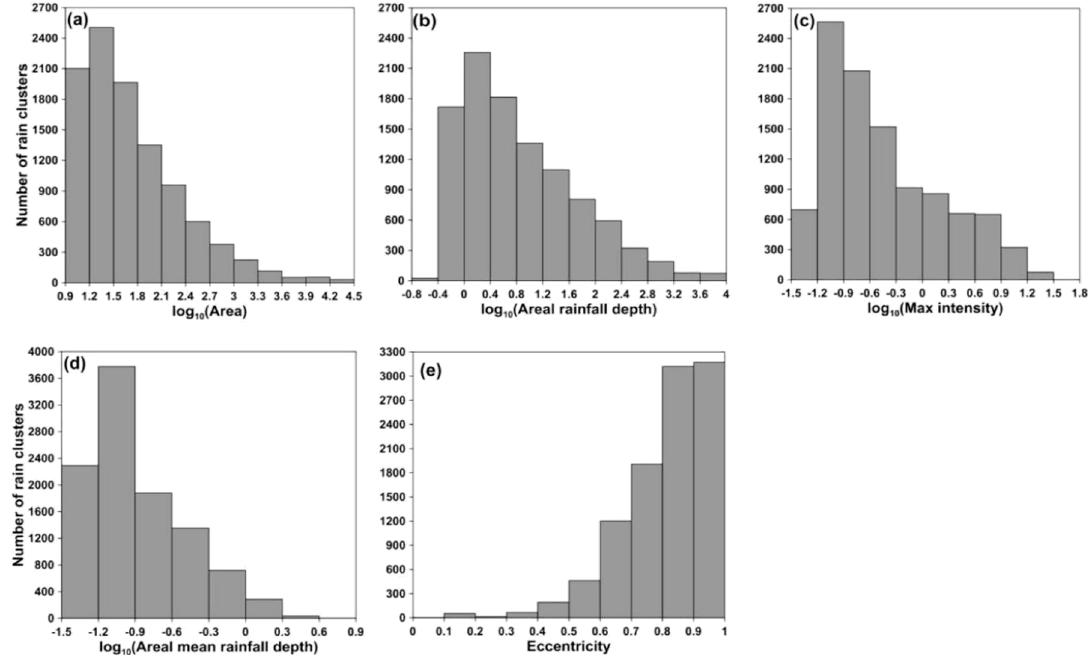
Figure 5. Histograms of log 10 -transformed rain cell properties: ( a ) area, ( b ) areal rainfall depth, ( c ) maximum intensity, ( d ) areal mean rainfall depth and property, ( e ) eccentricity for identified rain fields.